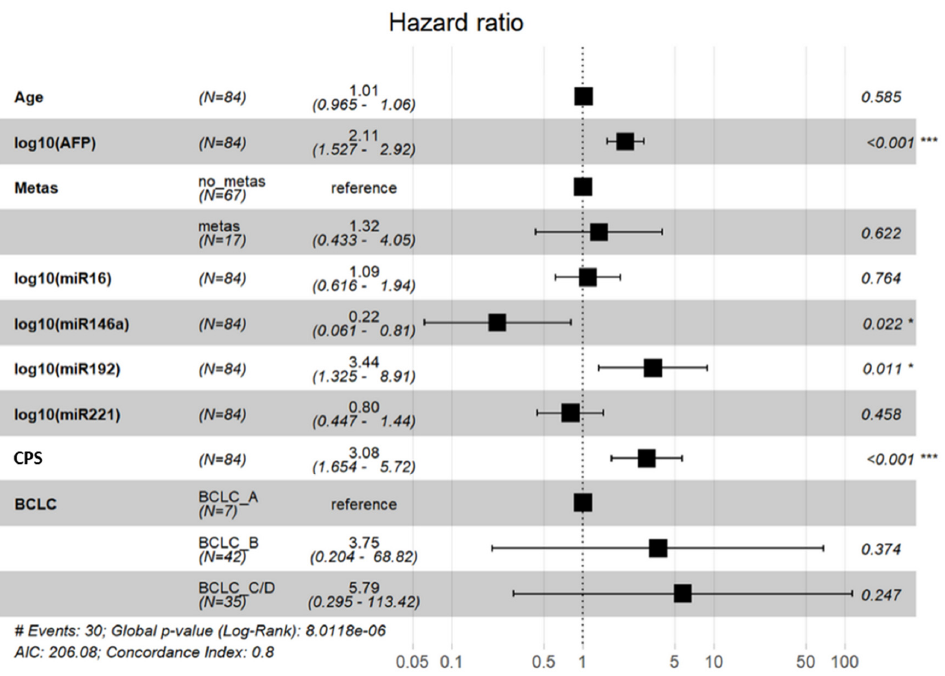
Figure 4. Association of exosomal miR-192 and miR-16 with poor outcome. Kaplan–Meier analyses show significant correlations of increasing levels of exosomal miR-192 in all HCC patients ( A ) and in patients of BCLC stage A and B ( B ). Decreased levels of exosomal miR-16 in liver cirrhosis patients significantly correlate with poor OS ( C ). As determined by the log-rank test, the significant p values of the statistical evaluations are indicated at the curves.